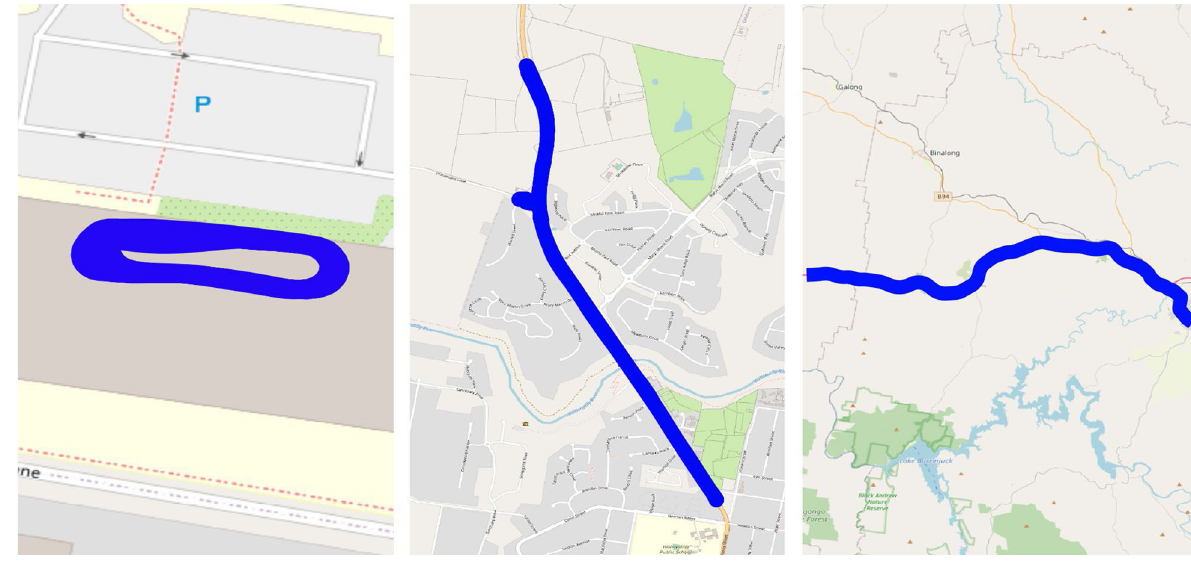
Fig. 7 Trajectories of three kinematic experiment